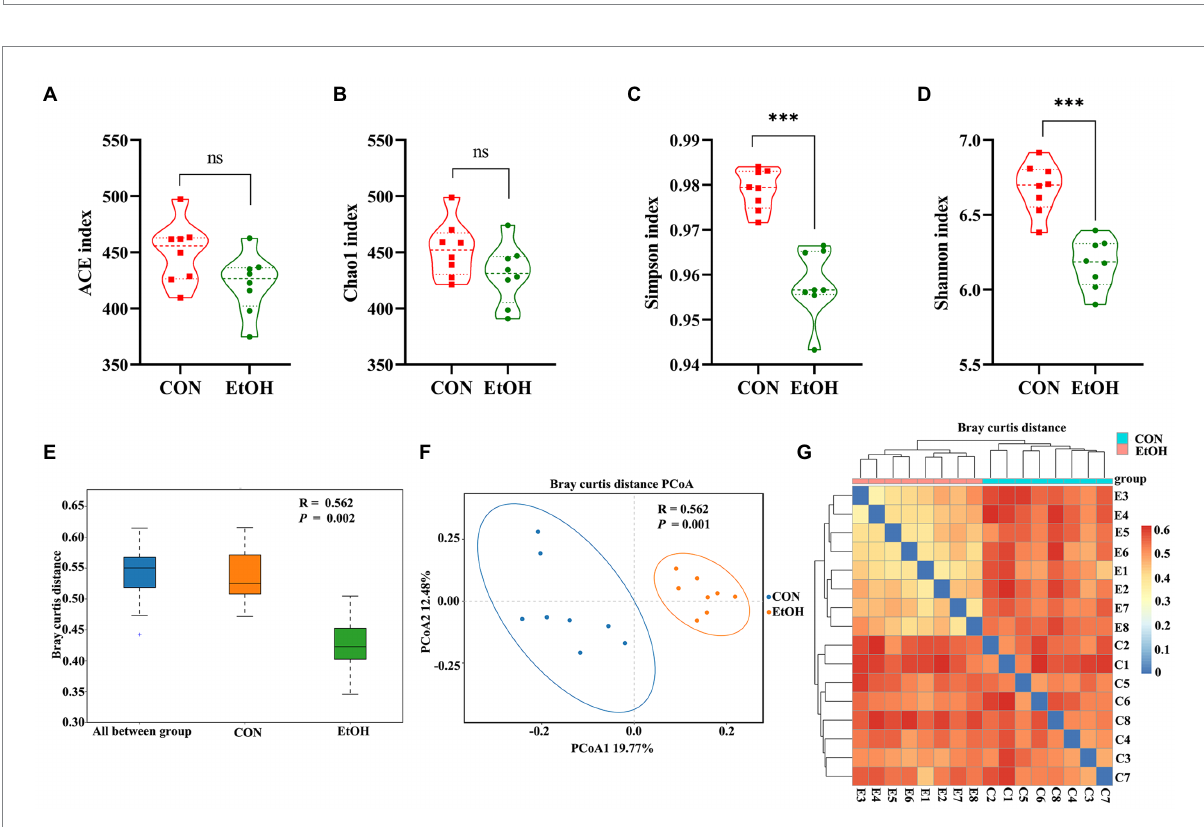
FIGURE 6 Chronic intermittent ethanol voluntary drinking alters the diversity of gut microbiota in rats. Difference in alpha diversity index between EtOH and CON group showed in the plot (A–D) . (A) represent ACE index; (B) represent Chao1 index; (C) respresent Simpson index; (D) represent Shannon index. The width of each curve in the violin plot corresponds with the approximate frequency of data points in each region, dotted line indicating the median value and quartile positions. Significant results were determined by unpaired t -tests, *** p < 0.001; ns, p > 0.05. (E) , ANOSIM analysis showed differences between EtOH and CON groups were significantly greater than those within groups. (F) PCoA plot based on Bray–Curtis distance, EtOH and CON groups could be effectively separated, showing that the composition of the gut microbiota in EtOH group was significantly different from that of CON group. (G) samples heat map based on the Bray–Curtis distance showed that the samples in the same group clustered together, indicating that EtOH changed the gut microbiota